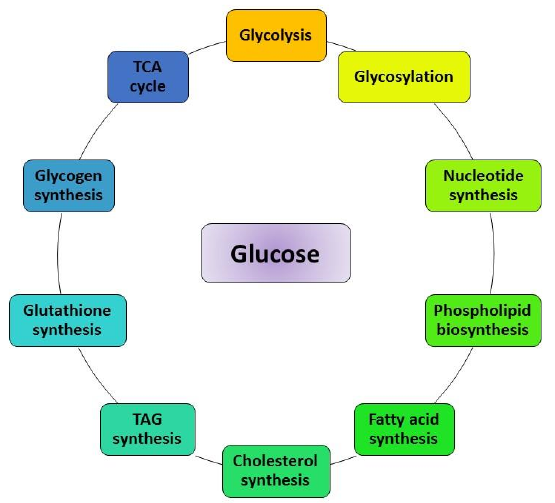
Figure 1. Biochemical fates of glucose. Glucose serves as a key molecule for fatty acid synthesis, cholesterol synthesis, TAG synthesis, glutathione synthesis, glycogen synthesis, phospholipid, and nucleotide